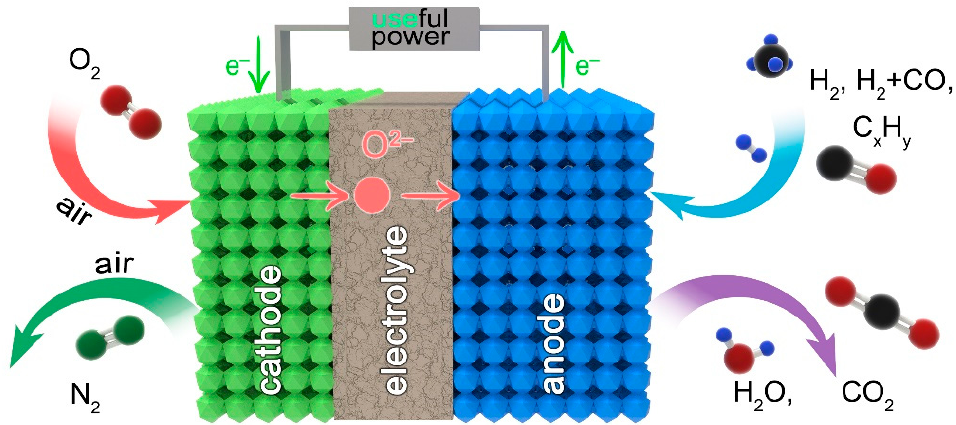
Figure 1. Simplified scheme of solid oxide fuel cells (SOFCs) working principle. During the operation of an SOFC, the cathode produces an oxygen reduction reaction (Reaction (1)) and delivers O 2 − ions to the contact point with the electrolyte.